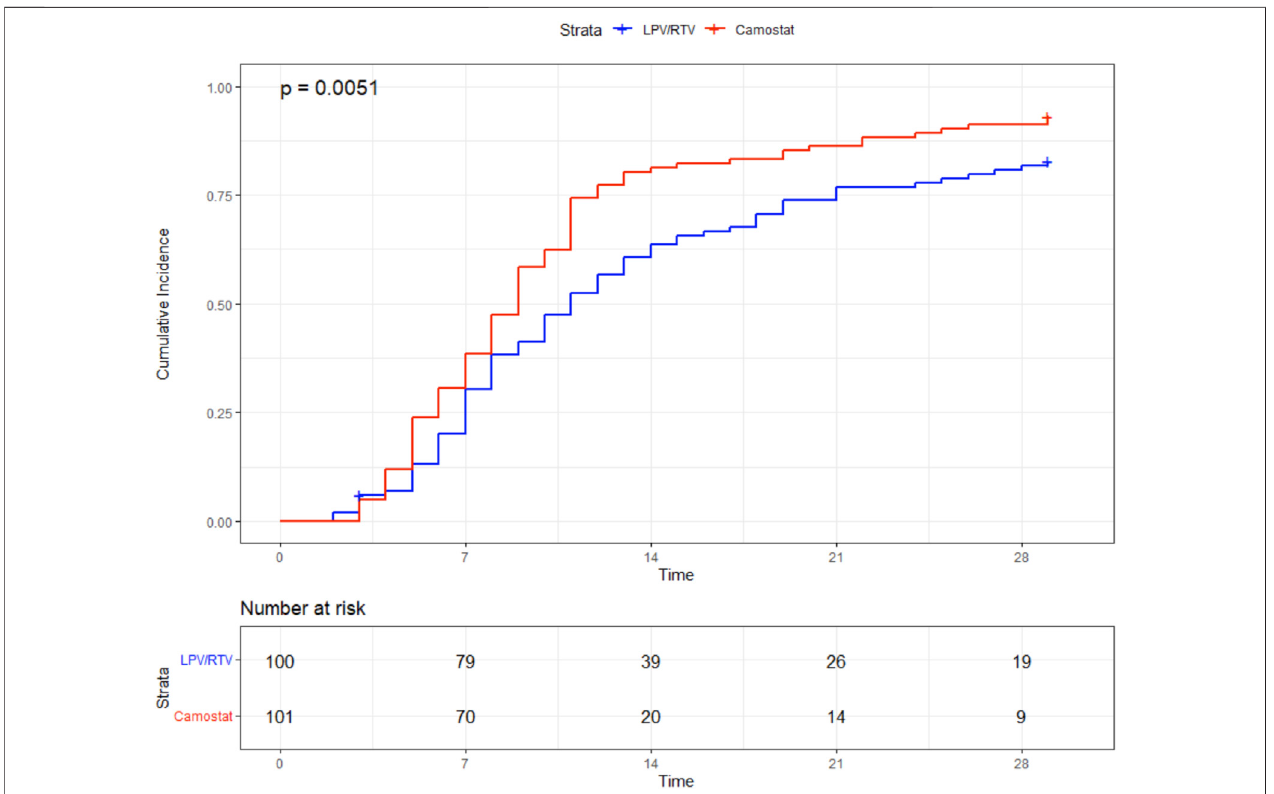
FIGURE 1 | Primary endpoint: time (in days) to sustained ( ≥ 48 h) improvement ≥ 1 point in the WHO clinical progression scale.